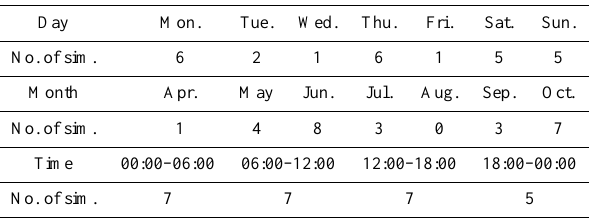
Table 1. Diurnal, weekly and monthly distribution of all 26 simu- lated cases. The time is given as local wintertime at the time when the trajectories arrived in